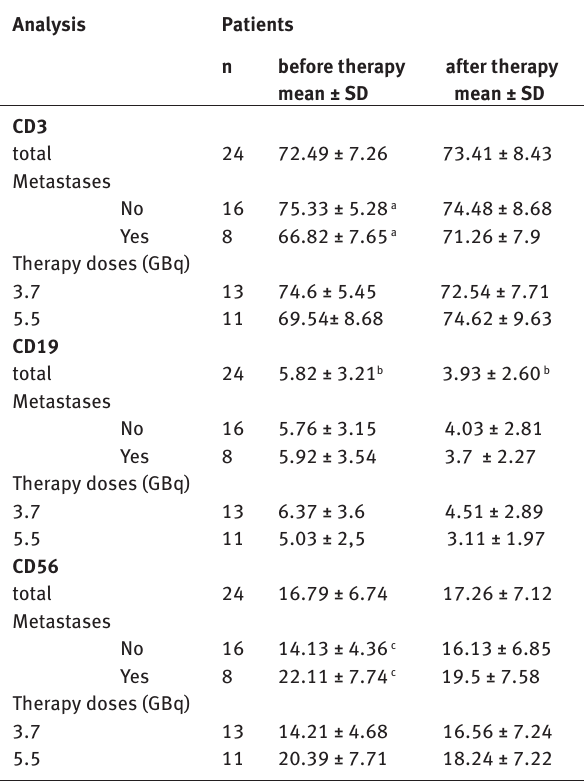
Table 4: Summarized results for CD3, CD19 and CD56-positive cells in PBLs of DTC patients before and after 131-I